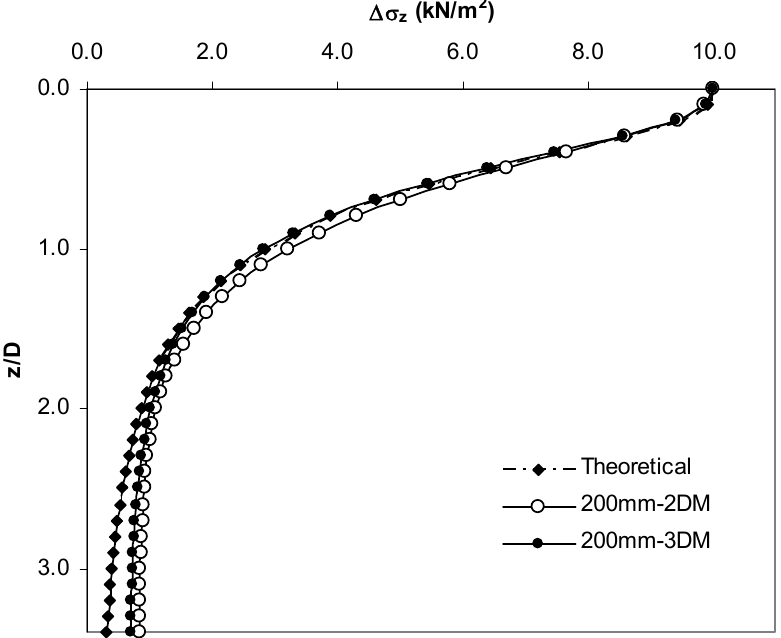
Figure 23. Vertical stress distribution (D = 200 mm).